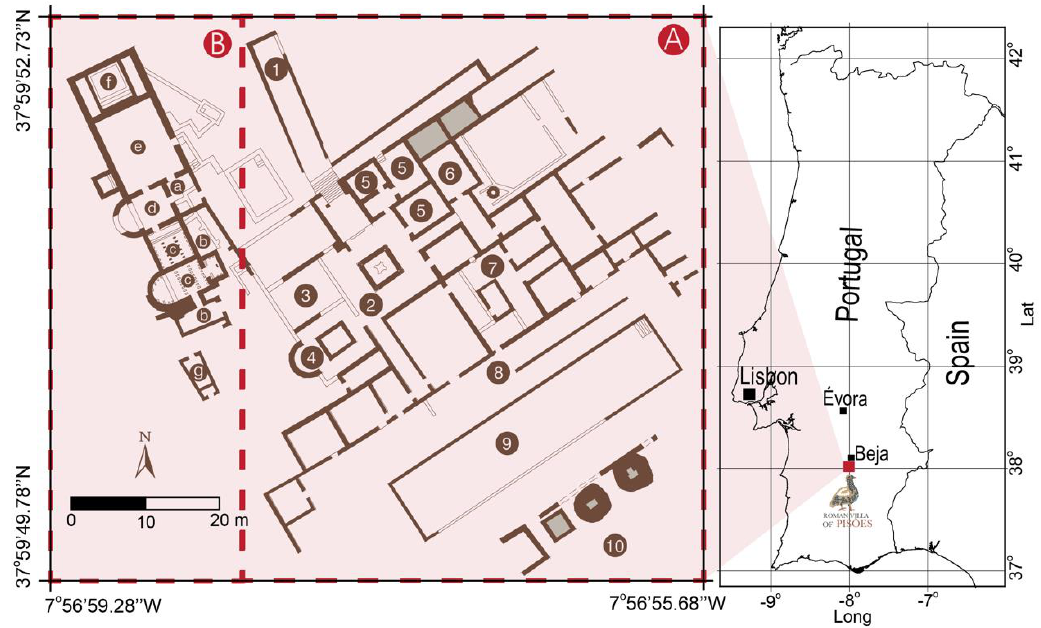
Figure 1. Localization of the Roman Villa of Pisões in Portugal map, and the plan view of the pars urbana with the ( A ) residential area and ( B ) thermal baths. 1. North entrance corridor, where the studied mosaics are located; 2. columned atrium; 3. reception room (tablinium); 4. dining room (triclinium); 5. bedrooms; 6. larder and kitchen; 7. former atrium with square basin for rainwater (implivium); 8. south porticoe; 9. swimming pool (natatio); and 10. mausoleums. In the baths: a. Dressing room (apodyterium); b. furnace (praefurnium); c. hot water room (caldarium); d. warm room (tepidarium); e. cooling room (frigidarium); f. swimming pool (natatio); and g. latrines.